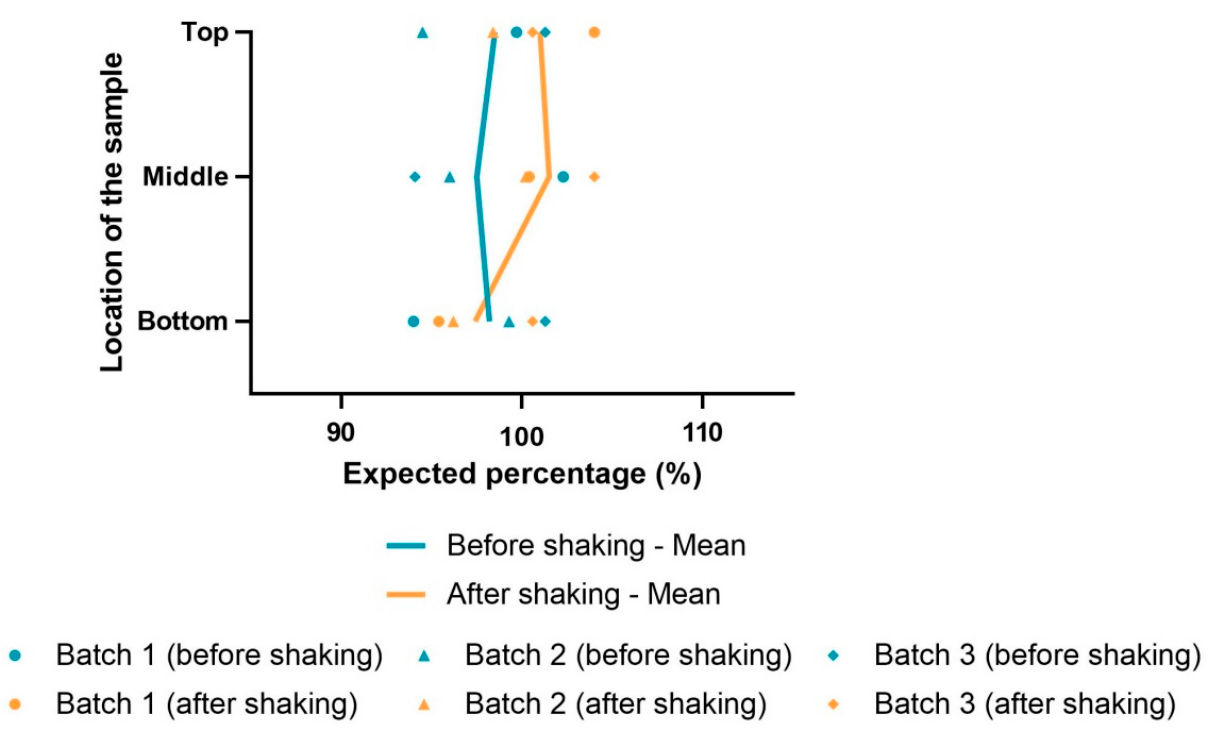
Figure 3. Uniformity of content of 50 mL bottles containing nicardipine hydrochloride 2 mg/mL formulation before and after agitation.